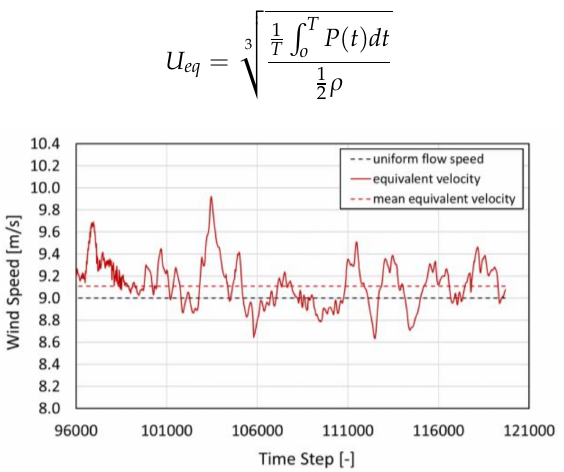
Figure 2. Comparison between a uniform wind speed, a real fluctuating one and its equivalent speed as in Equation